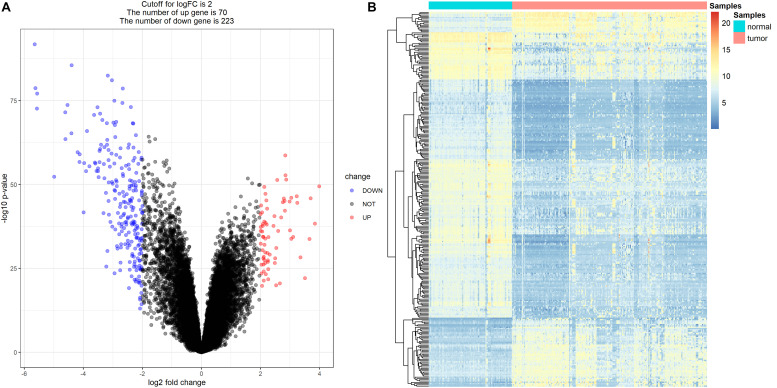
Differentially expressed genes (DEGs) screening. (A) Volcano plot visualizing the immune-related DEGs. (B) Heatmap for immune-related DEGs between tumor samples and normal samples (P < 0.05, fold change > 2).